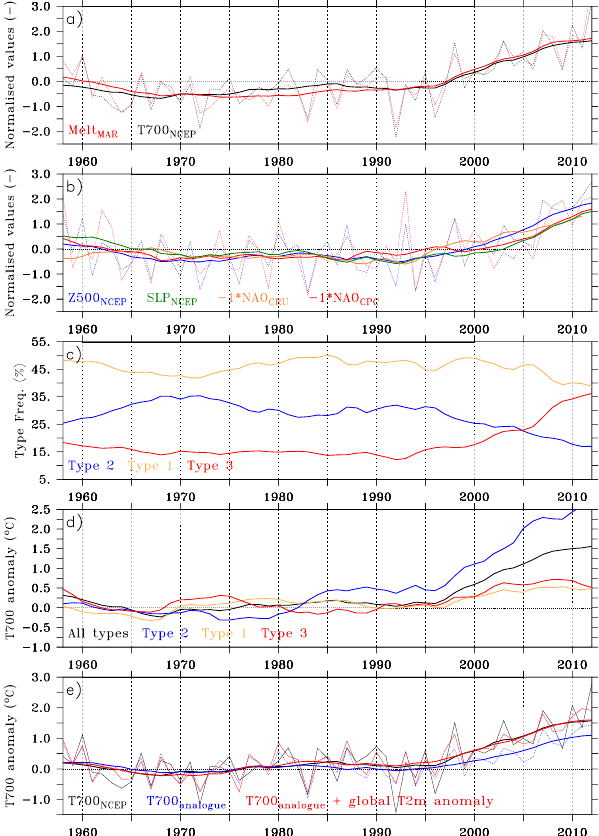
Fig. 1. (a) Normalised time series of the annual GrIS melt amount simulated by MAR (in red) and of the JJA T700 aver- aged over the area covering Greenland (20 ◦ W ≤ longitude ≤ 70 ◦ W and 60 ◦ N ≤ latitude ≤ 85 ◦ N) from the NCEP-NCAR reanalysis (in black). The smoothed lines show the 10-yr running mean of the time series. (b) Normalised time series of the JJA Z500 averaged over the area covering Greenland (in blue), of the JJA SLP (in green), of the Z500 based NAO index (in red) from the Climate Prediction Center (CPC) of the National Oceanic and Atmospheric Adminis- tration (NOAA) and of the SLP-based NAO index (in orange) from the Climate Research Unit (CRU). Here the sign of the NAO in- dexes time series has been changed to be consistent with the other time series. (c) Evolution (in percentage) of the number of occur- rences of each circulation class shown in Fig. 3 for each summer from 1958 to 2012. A 10-yr running mean is applied here. (d) Time series in ◦ C of the JJA T700 averaged over the area covering Green- land (in black) and of the T700 averaged over the days contained in each type of the CTC. Only 10-yr running means are shown here. The same figure using a 3-yr running mean is provided in the Sup- plement. Anomalies are relative to the 1961–1990 baseline period. (e) Time series in ◦ C of the JJA T700 averaged over the area cov- ering Greenland (in black), of the analogues-based T700 (in blue) and of the analogues-based T700 plus the anomaly of the global annual NCEP-NCAR 2-m-temperature (in red) compared with the 1961–1990